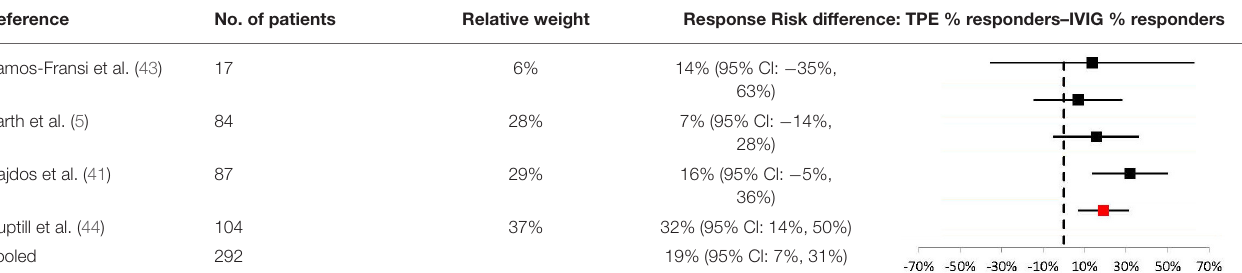
TABLE 3 | Meta-analysis results comparing response risk differences between TPE and IVIG in acute MG